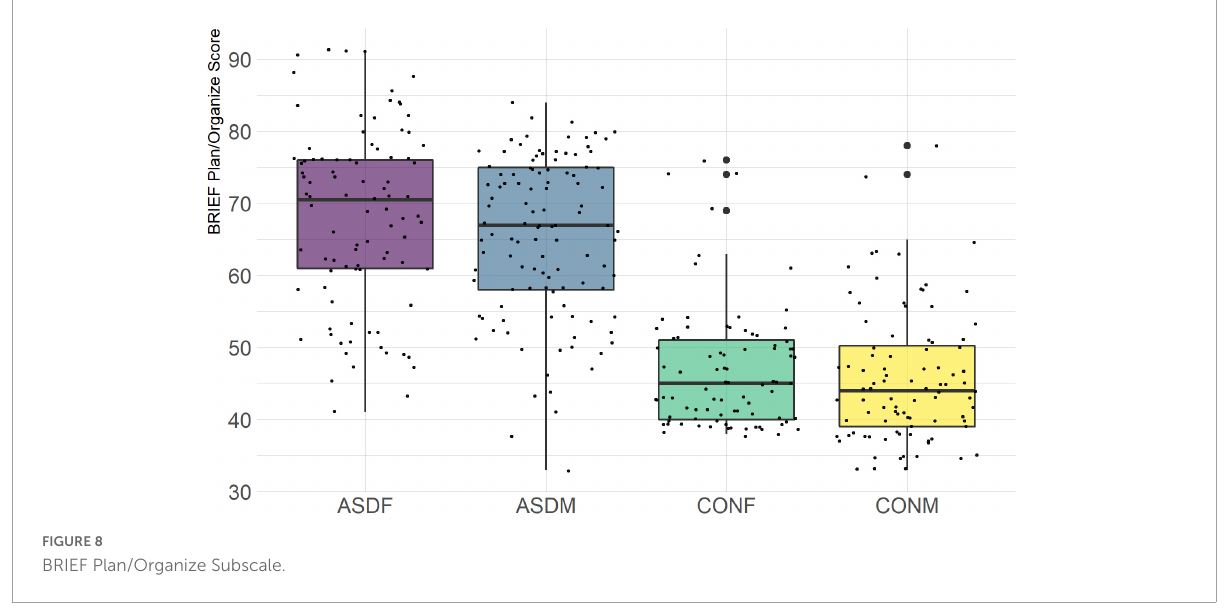
FIGURE8 BRIEF Plan/Organize Subscale.